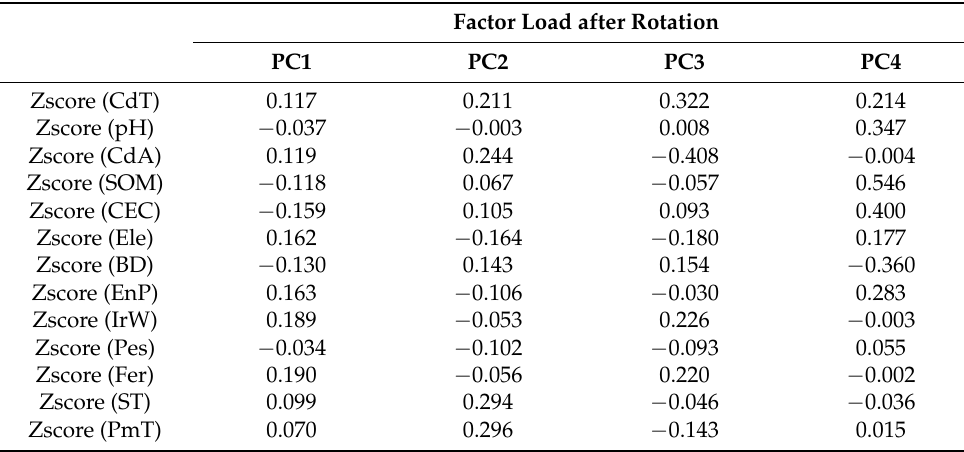
Table 5. A rotation matrix table showing nonlinear principal component analysis results. Factor Load after Rotation PC1